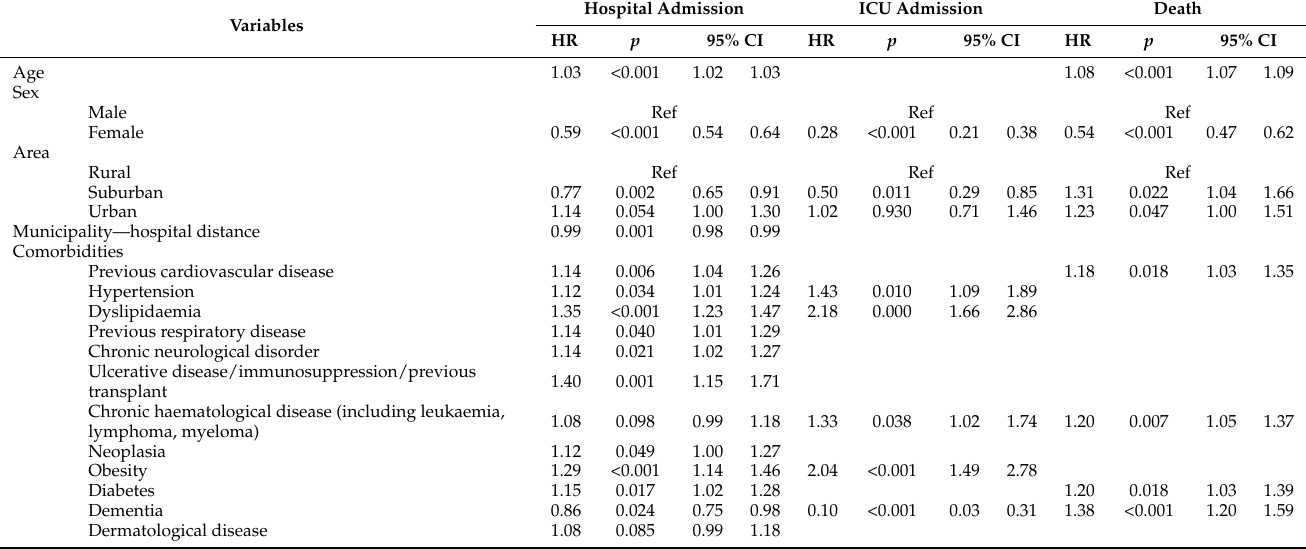
Table 3. Multivariate Cox